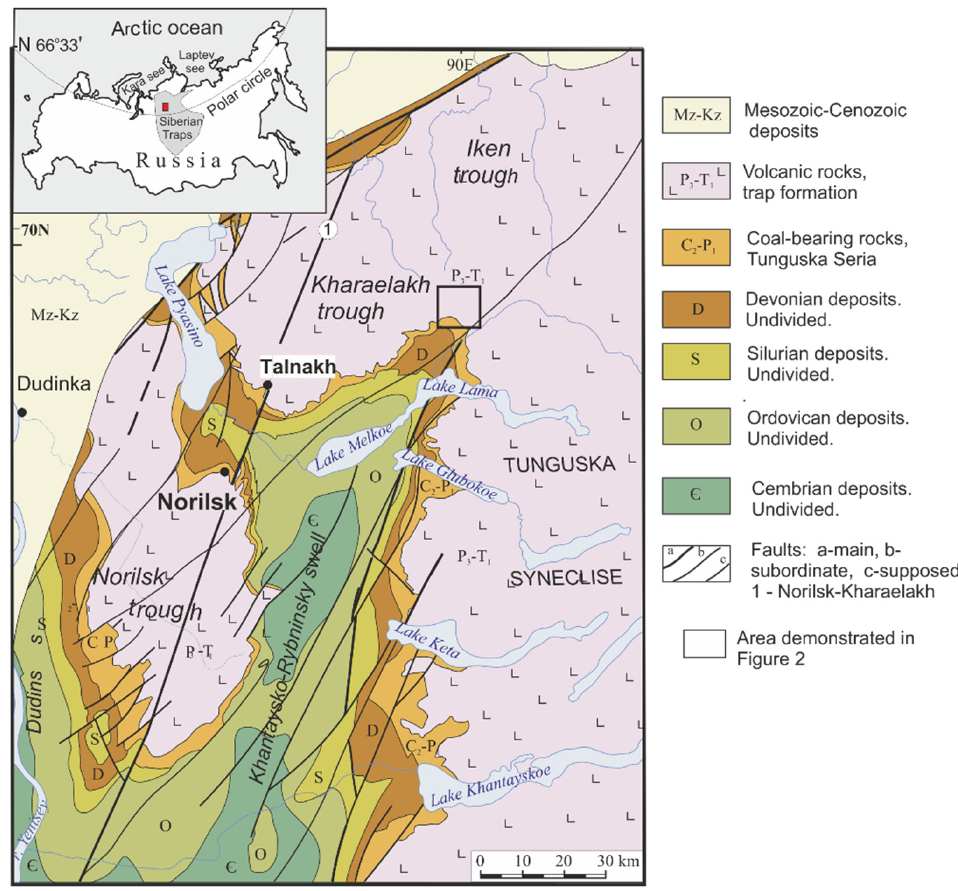
Figure 1. Schematic geology map of the Norilsk district. 1–Norilsk-Kharaelakh fault.